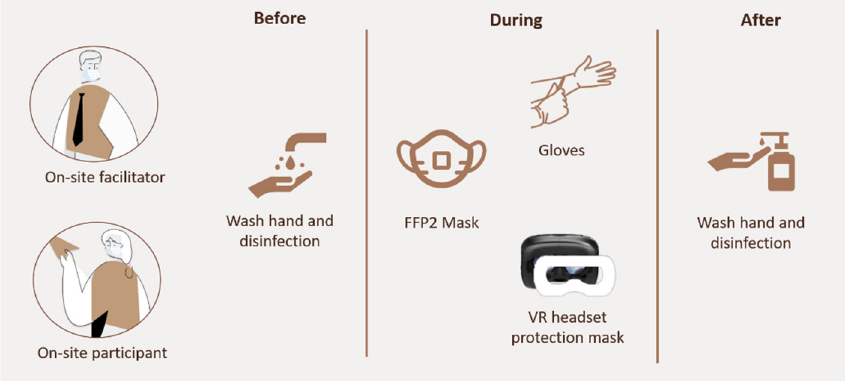
Figure 18. Safety measures taken by the on-site facilitators and participants throughout the user testing during the pandemic.